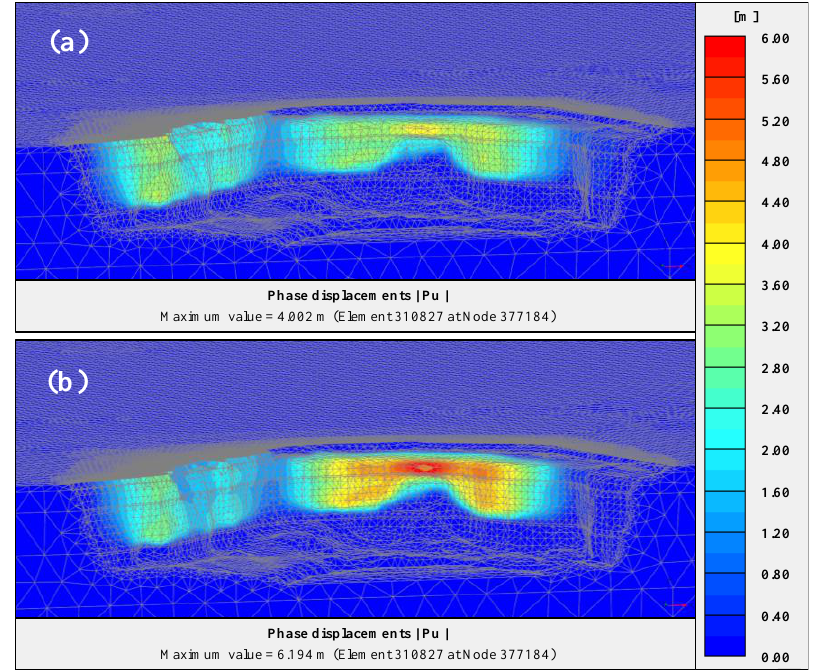
Figure 12. Displacements from safety phases of analyses: ( a ) pre- and ( b ) post- rock block detachment. The comparison between the contours corresponding to the situations of pre- and post-block detachment shows that, on the cliff, there are two zones prone to the general instability phenomena, and in the area where the deactivation of the volume material is simulated an increase of the deformation levels is obtained.